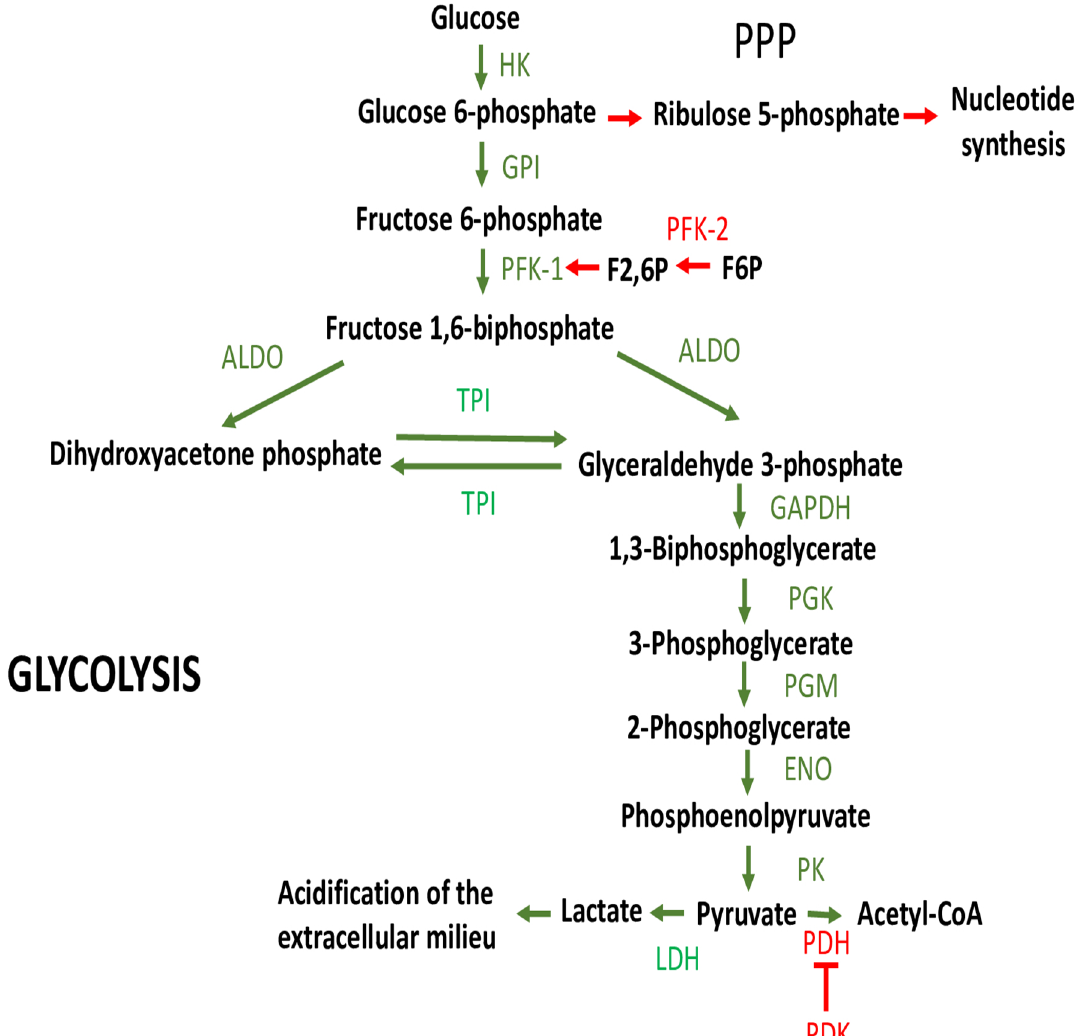
Figure 1. Glycolysis. Glycolytic enzymes and metabolites are depicted as well as some of the path- ways that branch off or that modulate steps in the glycolytic metabolism (see text for more details). Green arrows refer to steps that are inherent to glycolysis, red arrows to reactions that branch off or modulate glycolysis. ALDO, aldolase, fructose-bisphosphate; ENO, enolase; GAPDH, glycer- aldehyde 3-phosphate dehydrogenase; GPI, glucose 6-phosphate isomerase; HK, hexokinase; LDH, lactate dehydrogenase; PDH, pyruvate dehydrogenase; PDK, pyruvate dehydrogenase kinase; PFK-1, phosphofructokinase-1; PFK-2, phosphofructokinase-2 (including the isoforms 6-phosphofructo-2- kinase/fructose-2,6-biphosphatase 3 (PFKFB3) and PFKFB4); PGK, phosphoglycerate kinase; PGM, phosphoglycerate mutase; PK, pyruvate kinase; PPP, pentose phosphate pathway; TPI, tri- osephosphate isomerase.